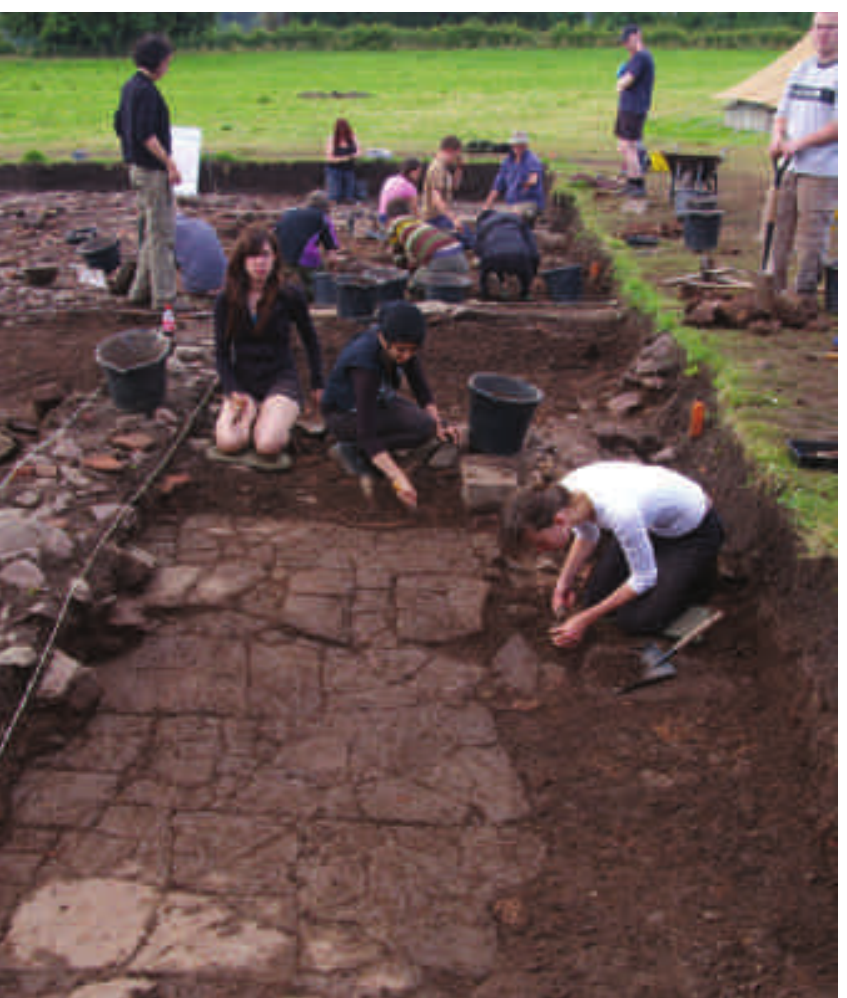
Figure 5 A late alteration to the store-building: a new flagged passage-way, under excavation